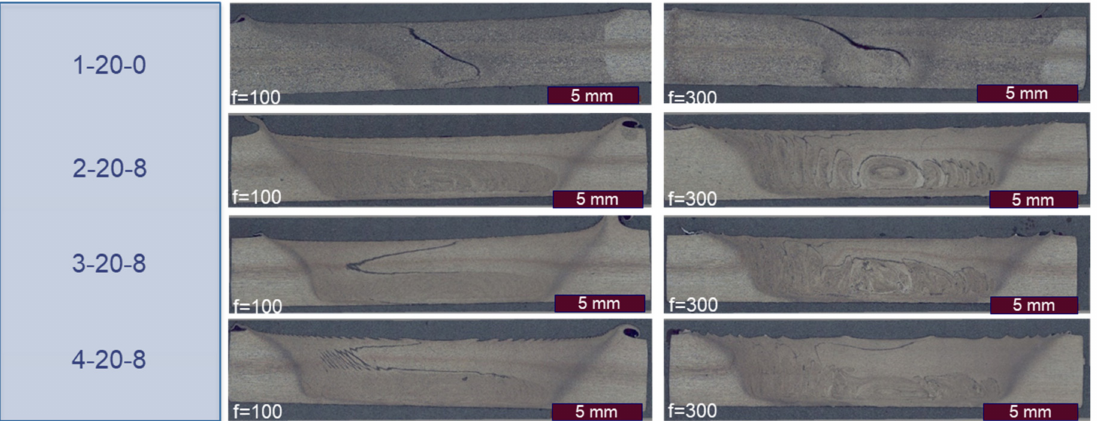
Figure 5. Oxide line distribution using a marker